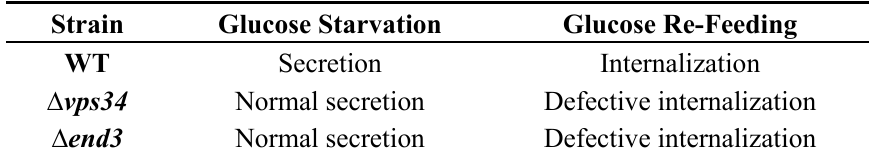
Table 1. FBPase distribution in wild-type, ∆ vps34 , and ∆ end3 mutant strains during glucose starvation and following glucose